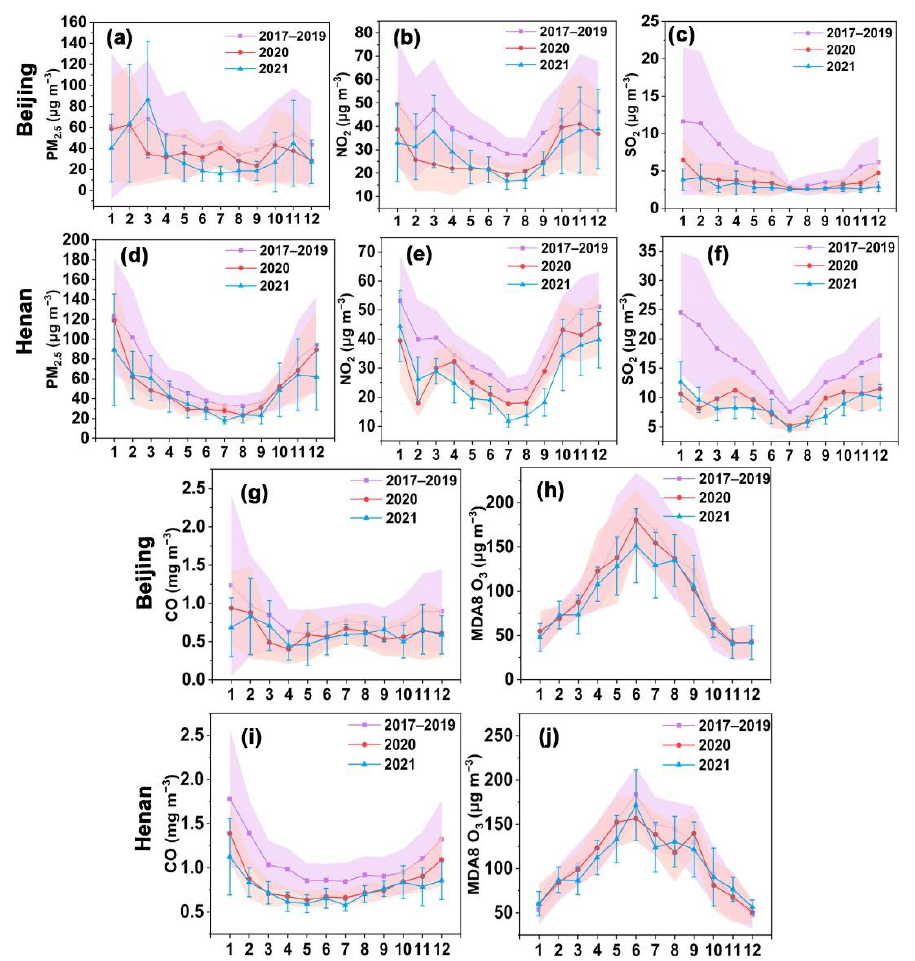
Figure 3. Monthly variations in the concentrations of PM 2.5 , NO 2 , SO 2 , CO, and MDA8 O 3 during 2017 – 2021 in Beijing and Henan. ( a – c , g , h ) show monthly concentrations of PM 2.5 , NO 2 , SO 2 , CO, and MDA8 O 3 during 2017 – 2021 in Beijing, respectively, and ( d – f , i , j ) show monthly concentrations of PM 2.5 , NO 2 , SO 2 , CO, and MDA8 O 3 during 2017 – 2021 in Henan, respectively. The light-shaded areas or error bars represent the standard deviation.